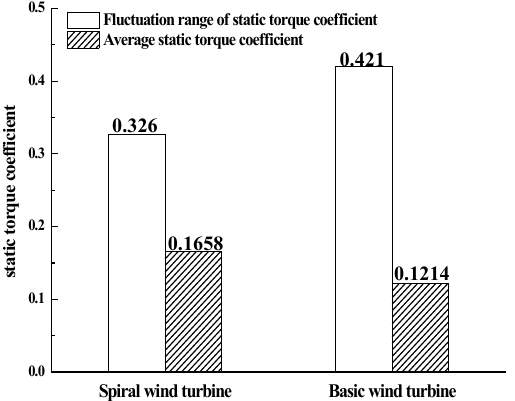
Figure 9. The range and average of static torque coefficient.